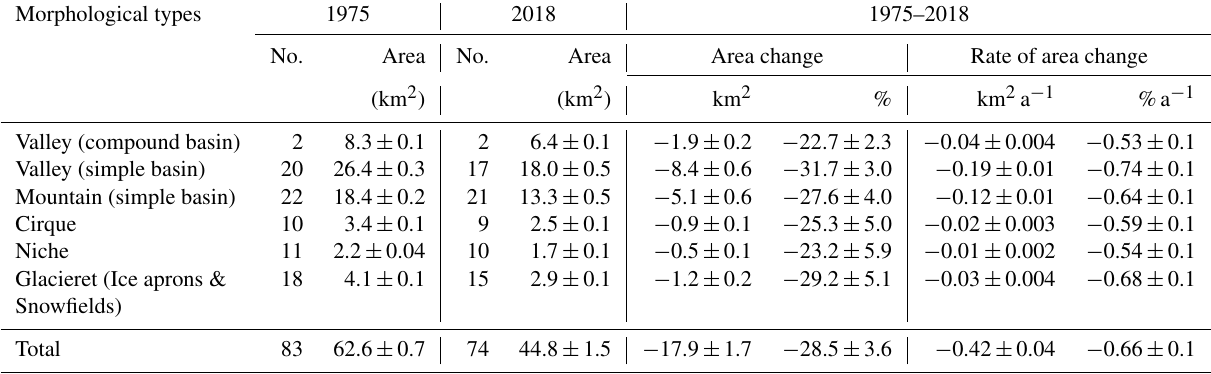
Table 7. Comparison of glacier inventory within the study region (CCW). Sl. Glacier No.